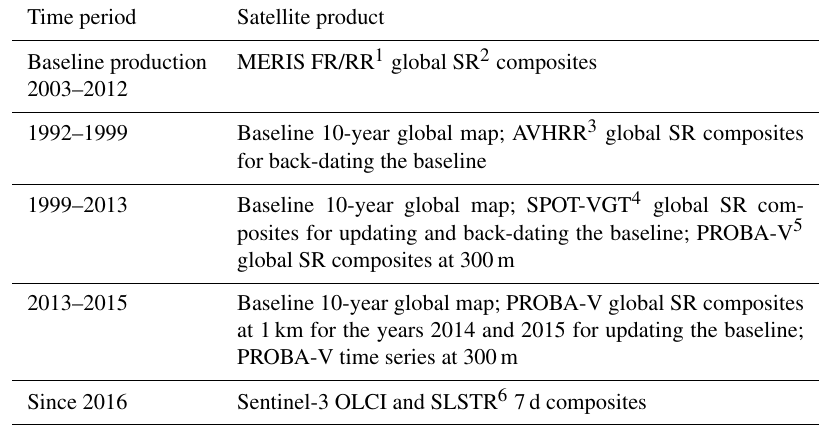
Table 2. Satellite missions involved in the production of ESA-CCI LC according to ESA (2017a).